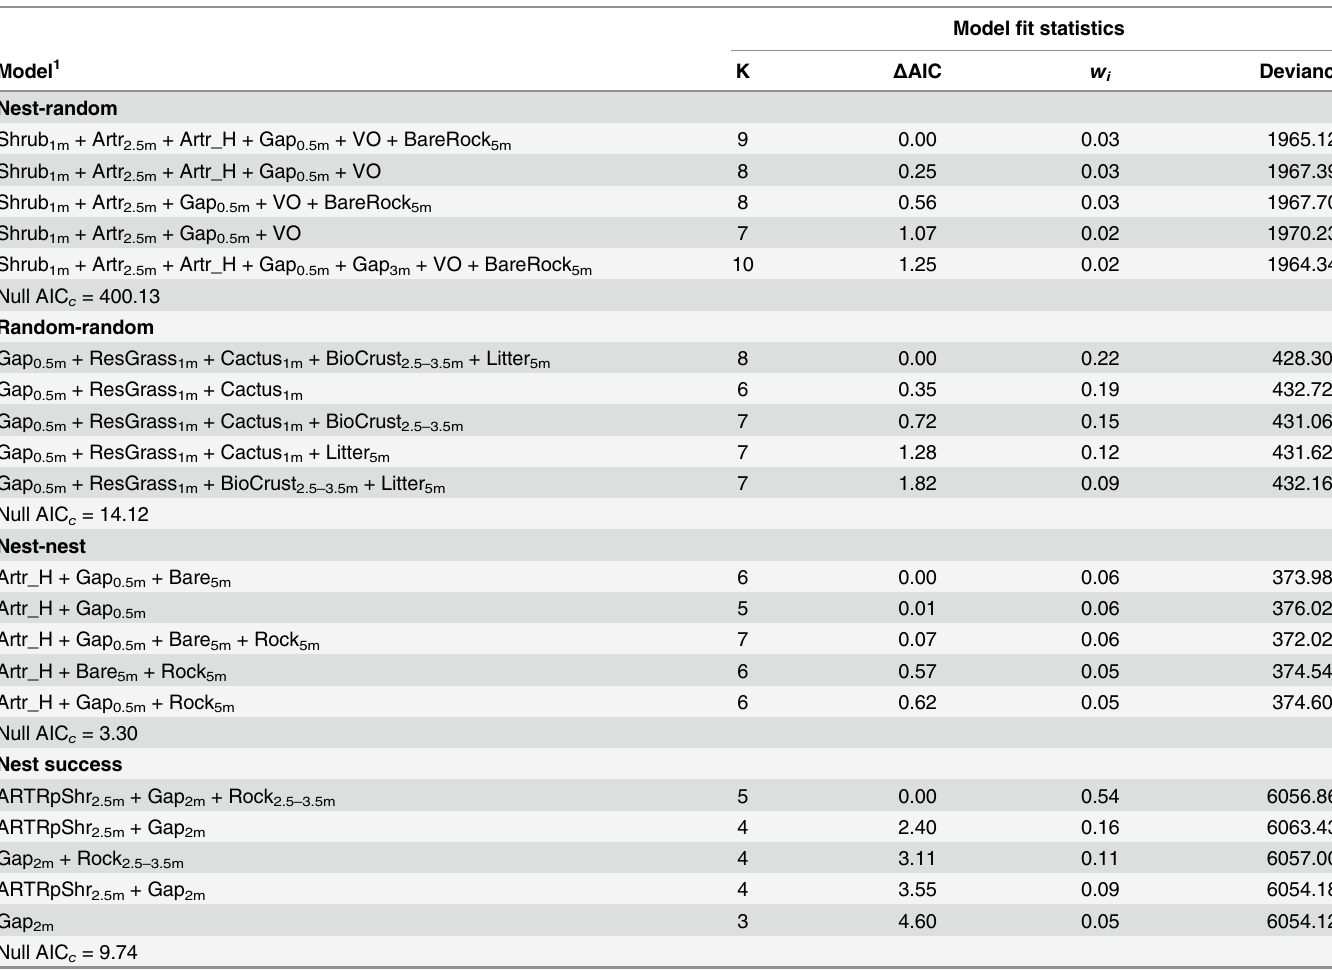
Table 3. Model comparisons of binomial generalized linear mixed models evaluating nest-site selection of sage-grouse (nest-random), availability of microhabitat within and outside of Core Areas (random-random), and sage-grouse use of microhabitat within and outside of Core Areas (nest- nest). Cox proportional hazard models were used to evaluate nest success of sage-grouse within and outside of Core Areas. Top five models for each analy- sis type were compared with Akaike ’ s information criterion (adjusted for small sample sizes; AIC c ) and Akaike weights ( w i ). Nests and random locations were located in five distinct study areas ( n = 928 nests, n = 819 random locations, and n = 924 nests with survival data) throughout central and southwestern Wyo- ming, USA, 2008 –